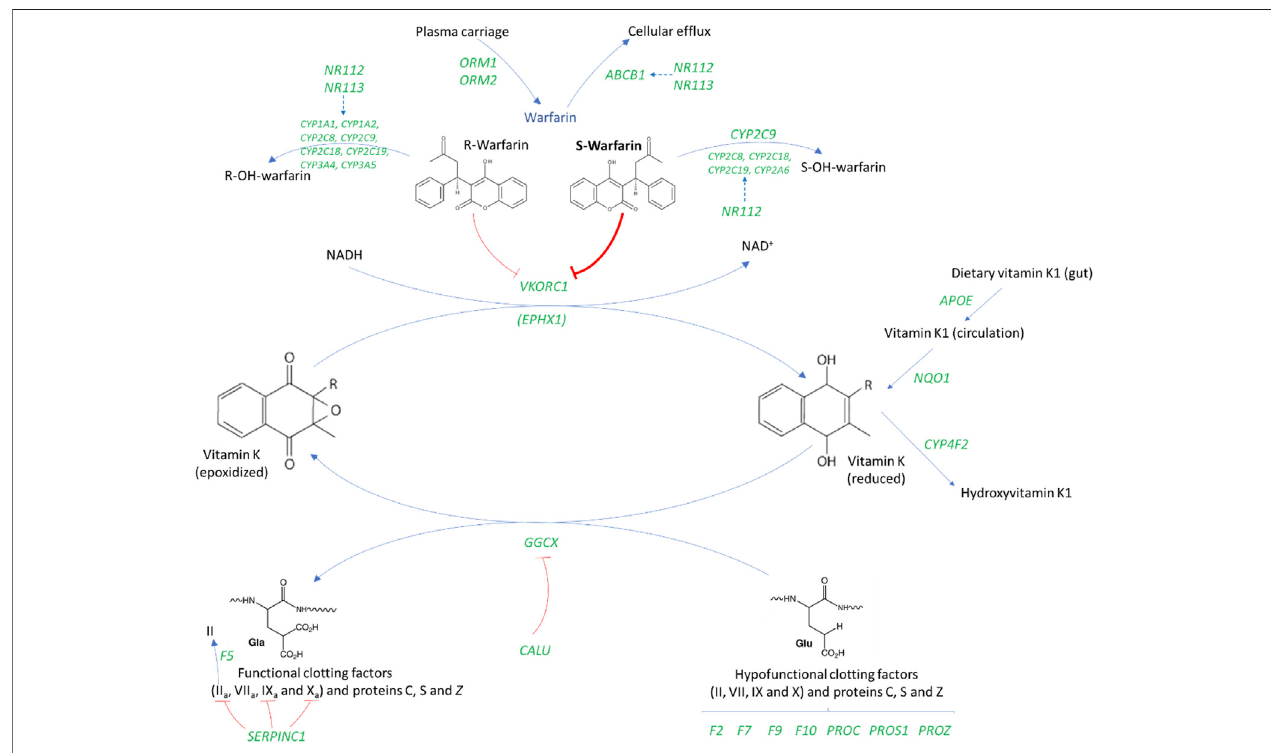
FIGURE 1 | An overview of the genes involved in warfarin ’ s mechanism of action (Wadelius et al., 2007; Wadelius and Pirmohamed, 2007). ABCB1 , ATP Binding Cassette Subfamily B Member one; APOE , Apolipoprotein E; CALU , Calumenin; CYP , Cytochrome P450; EPHX1 , Epoxide hydrolase one; GGCX , Gamma-glutamyl carboxylase; F2 , Coagulation factor II gene or prothrombin; F5 , Coagulation factor V gene; F7 , Coagulation factor VII gene; F9 , Coagulation factor IX gene; F10 , CoagulationfactorX; NQO1 ,NAD(P)Hdehydrogenase,quinoneone; NR1I2/3 ,NuclearReceptorSubfamily1GroupIMember2/3; ORM ,Orosomucoid; PROC , Protein C; PROS1 , Protein S; PROZ , Protein Z; SERPINC1 , Serpin Family C Member one; VKORC1 , Vitamin K epoxide reductase complex subunit 1. Gene names are italicized and shown in